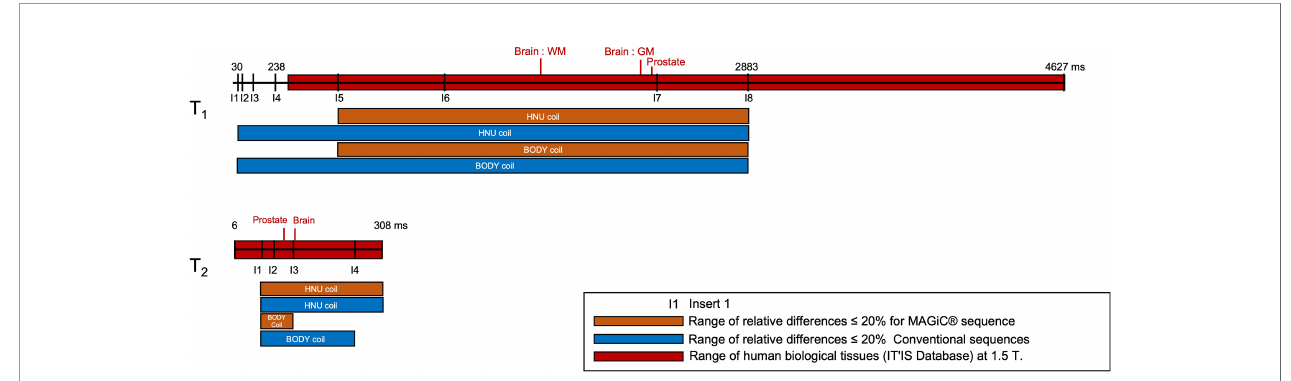
FIGURE 4 | Comparisons of the results of the relative differences ≤ 10% (except inserts 5, 7, and 8, where the results were slightly higher and given on the diagram) of the T 1 and T 2 mappings for the MAGiC ® method ( thick orange line ) and the conventional method ( thick blue line ) for the range of values measured on phantom compared to the reference values ( dotted line mark ), to the range of human biological tissues (30) at 1.5 T ( thick red line mark ), and to the range of human biological tissues of interest for radiotherapy planning at 1.5 T ( green line mark